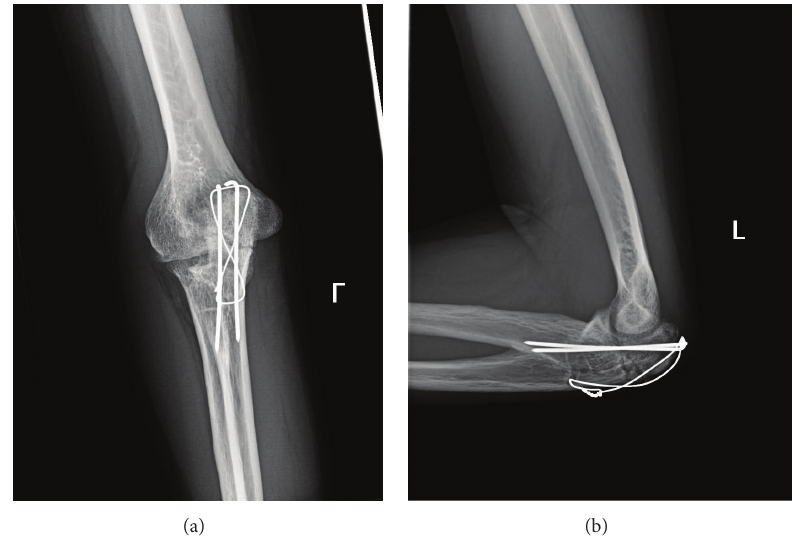
Figure 6: Young adult male with history of Rothmund-Thomson syndrome diagnosed at 2 years of age. Findings: no bridging bone formation had occurred at the two-month follow-up radiograph of the olecranon fracture. Technique: lateral radiograph kVp = 60, mAs =